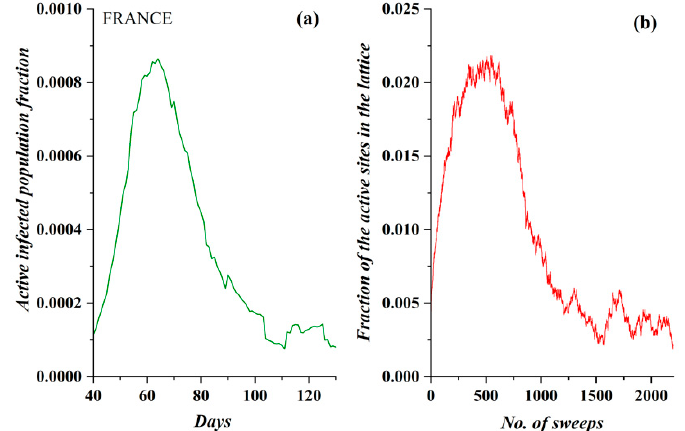
Figure 3. ( a ) The fraction of the active COVID-19 infected population daily in France (after 5 March 2020). Note that three phases are clearly distinguished. ( b ) The order parameter of the self-organizing diffusion model (SODM), namely the fraction of active lattice sites; the simulation vs. the number of lattice sweeps is presented for ρ = 0.055.